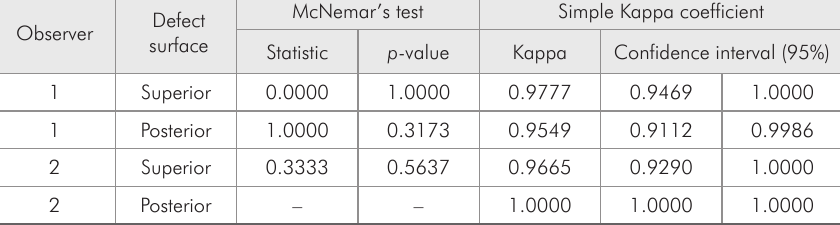
Table 2 - Intra-rater reliability